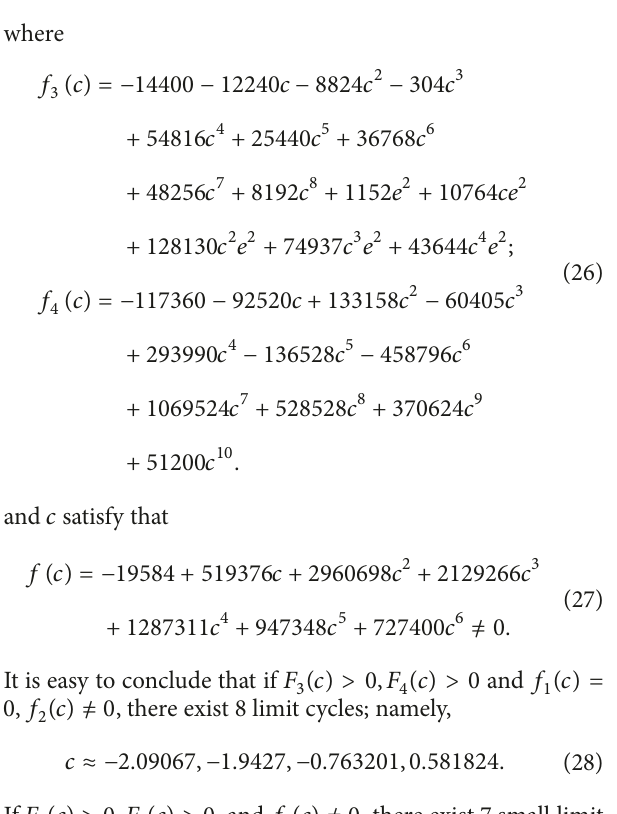
Figure 4: When 𝑐 = −√2/2 , an invariant algebraic curve 𝑥 2 − (√2/2)𝑦 2 = 1 and seven small limit cycles.